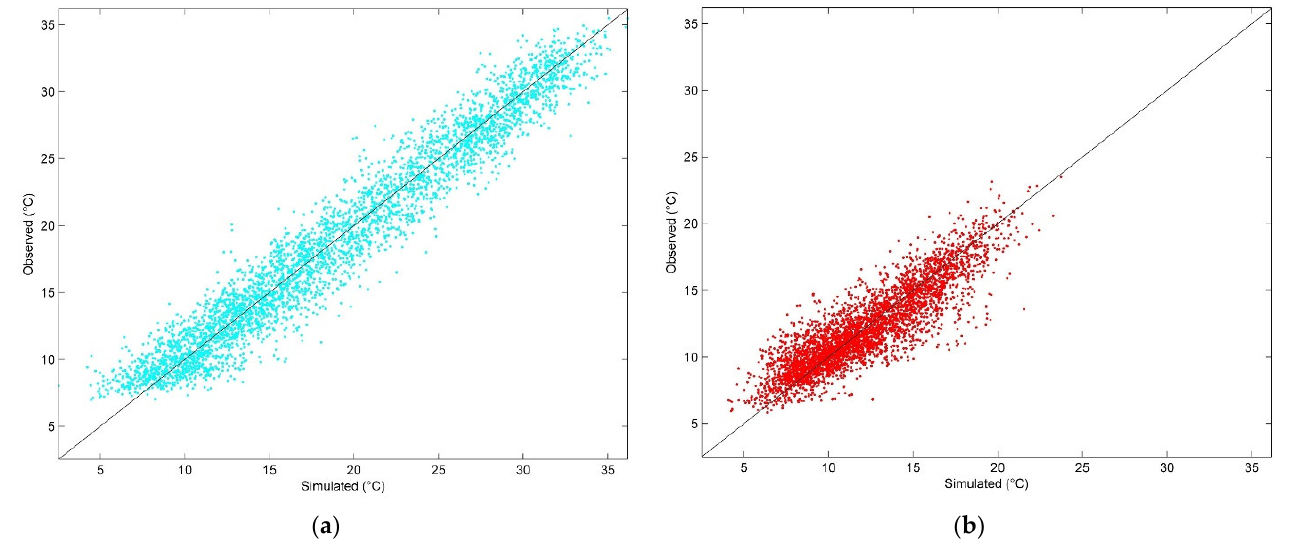
Figure 11. Scatter plots for observed skewness coefficient versus generated (mean 66 years observed and 1000 simulated series) for two models: ( a ) maximum temperature for each calendar day (blue) and ( b ) temperature range for each calendar day (red).